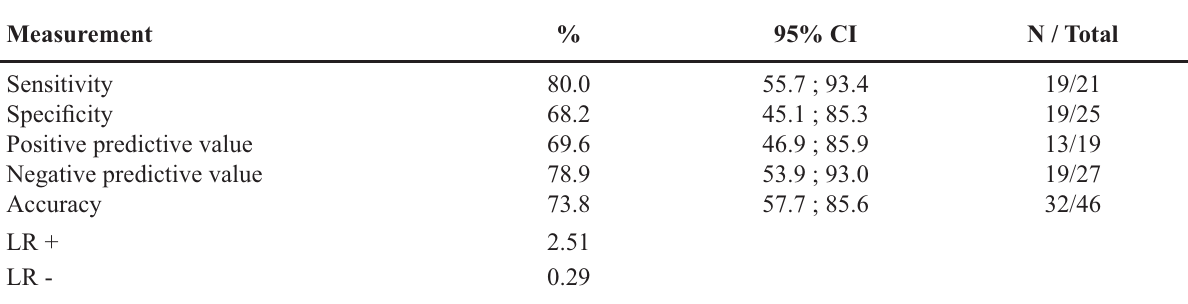
Table 3 – IPP grade III accuracy. Measurement